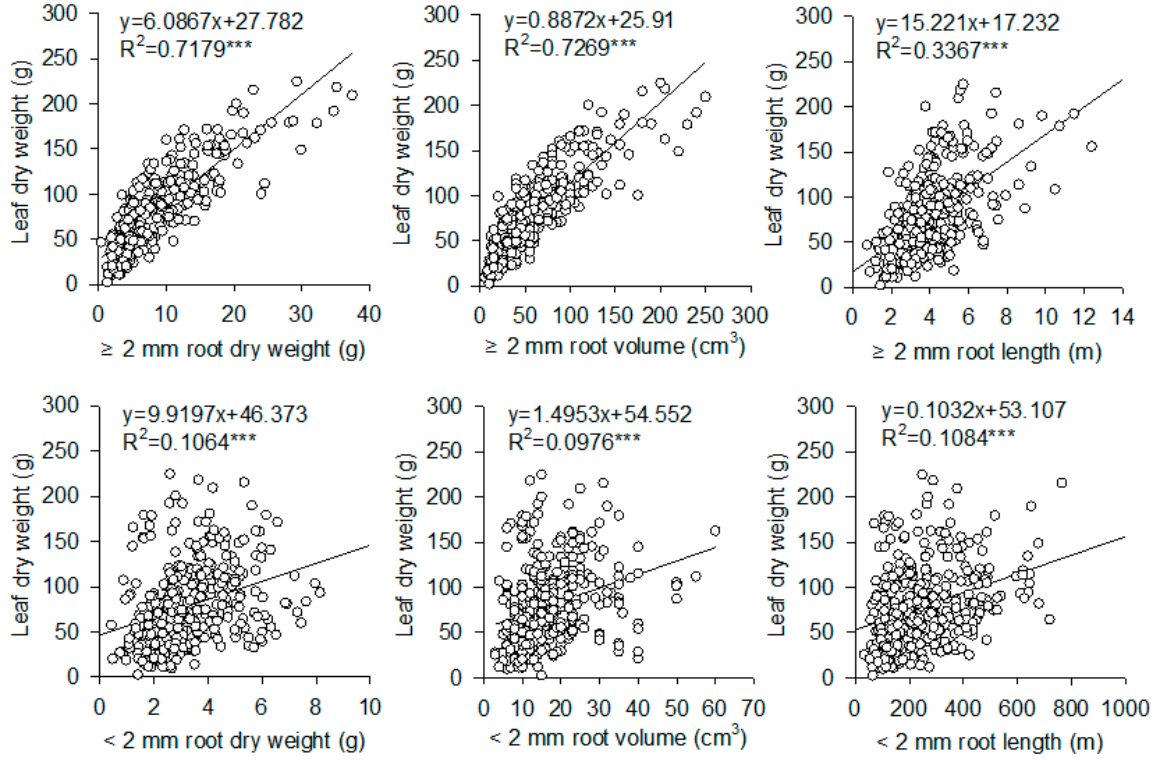
Figure 3. Regression between the leaf dry weight and root dry weight, volume, and length of the roots with a diameter ≥ 2 mm or < 2 mm. n = 360. Significant level: ***, p < 0.001.